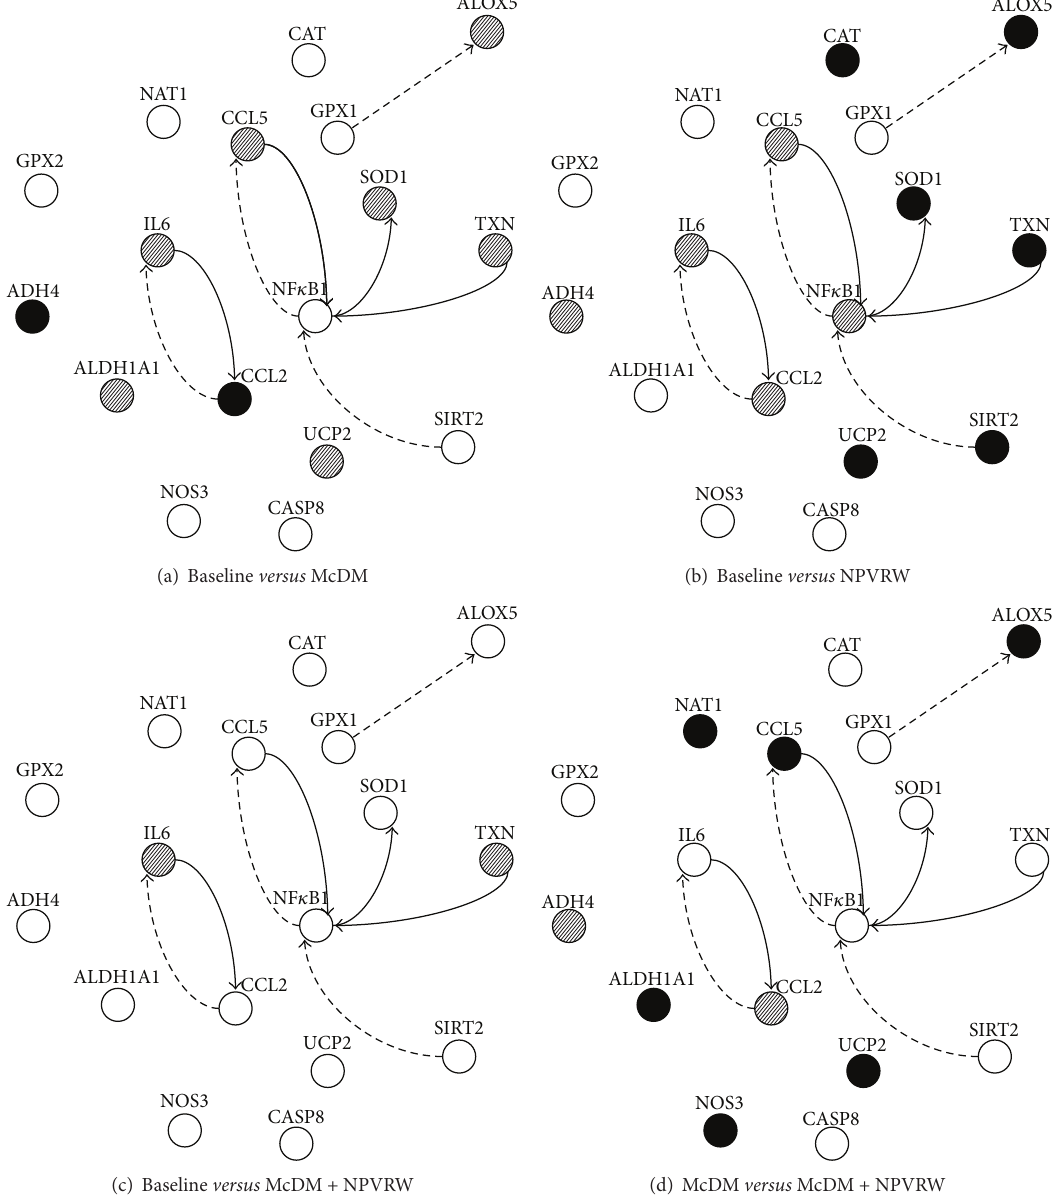
Figure 7: Nutrigenomic networking. Network showing upregulation (solid arrows) and downregulation (dashed arrows) of genes involved in inflammation, oxidative stress, and drug metabolism, in comparison with (a) baseline versus McD, (b) baseline versus NPVRW, (c) baseline versus McD + NPVRW, and (d) McD versus McD + NPVRW. Filled circle indicates upregulation in response to treatment; dashed circle indicates downregulation in response to treatment; empty circle indicates not significant genes. Oxidative stress genes : CAT , Catalase (NM 1752); GPX1 , Glutathione Peroxidase 1 (NM 581); GPX2 , Glutathione Peroxidase 1 (gastrointestinal) (NM 2083); UCP2 , Uncoupling Protein 2 (Mitochondrial Proton Carrier) (NM 3355); SOD 1 , Superoxide Dismutase 1 Soluble (NM 454); NOX4 , Nadph. Oxidase 4 (NM 16931); ALB , Albumin (NM 477); CCL5 , Copper Chaperone for Superoxide Dismutase (NM 2985). Inflammasome genes : CASP8 , Caspase 1 Apoptosis Related Cysteine Peptidase (NM 1228); NFKB1 , Nuclear Factor of Kappa Light Polypeptides Gene Enhancer in B-Cells 1 (NM 3998); CCL2 , Chemokine (C-C motif) Ligand 2 (NM 2982); PYCARD , Pyd and Card Domain Containing (NM 13258); RPLP0 , Ribosomal Protein Large P0 (NM 1002); NLRP12, Nrl Family Pyrin Domain Containing 12 (NM 33297); IL 6, Interleukin 6 (Interferon Beta 2) (NM 600). Human Drug Metabolism genes : NAT1 , N-Acetyltransferase 1 (Arylamine N-Acetyltransferase) (NM 662); NOS3 , Nitric Oxide Synthase 3 (Endothelial Cell) (NM 603); APOE , Apolipoprotein E (NM 41); ADH4, Alcohol Dehydrogenase 4-Class 2 Pi Polypeptide (NM 670); ALOX15 , Arachidonate 15-Lipoxygenase (NM 1140); ALOX5 , Arachidonate 5-Lipoxygenase (NM 698); HSD17 B2 , Hydroxysteroid (17 Beta) Dehydrogenase 2 (NM 2153); ALDH1A1 , Aldehyde Dehydrogenase 1 Family Member A1 (NM 689); MT2A , Metallothionein 2a (NM